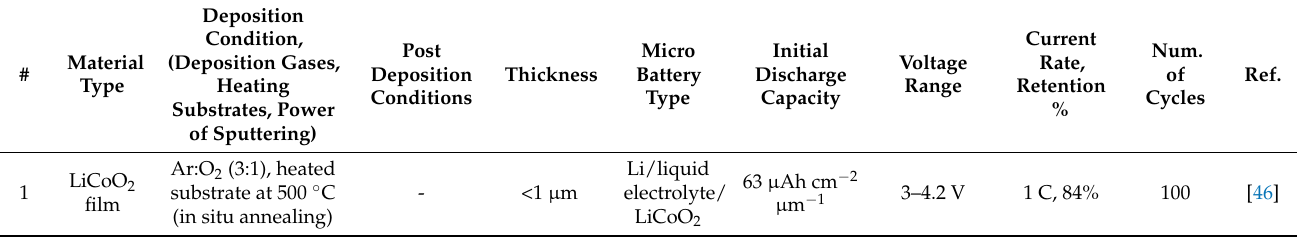
Table 1. Summarized table with existing scholar-collected data for LiCoO 2 thin-film